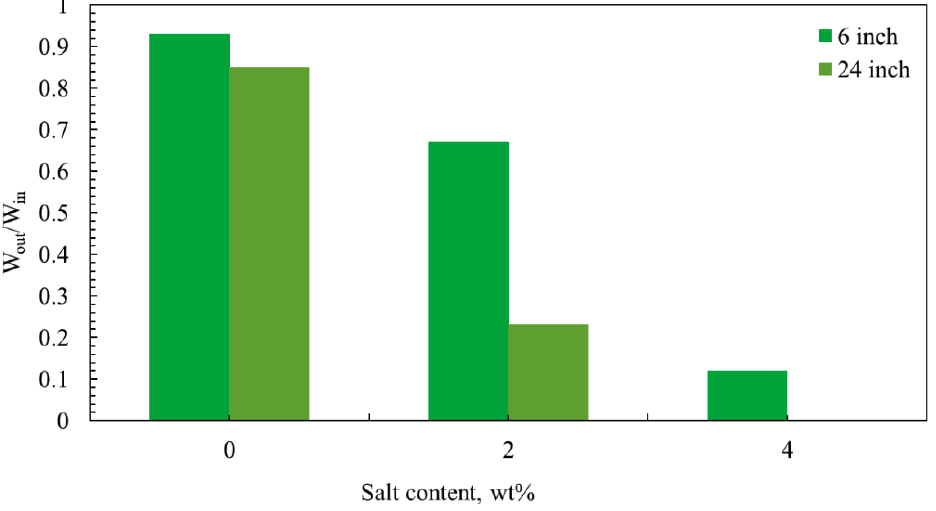
Figure 6. Visual representations of the nanofluids in the laboratory. 3.4. Future Research Direction: Rise of AI Artificial intelligence (AI) is an emerging field of technology which has wider appli- cations in this industrial age. AI can help the hydrocarbon companies perform predictive